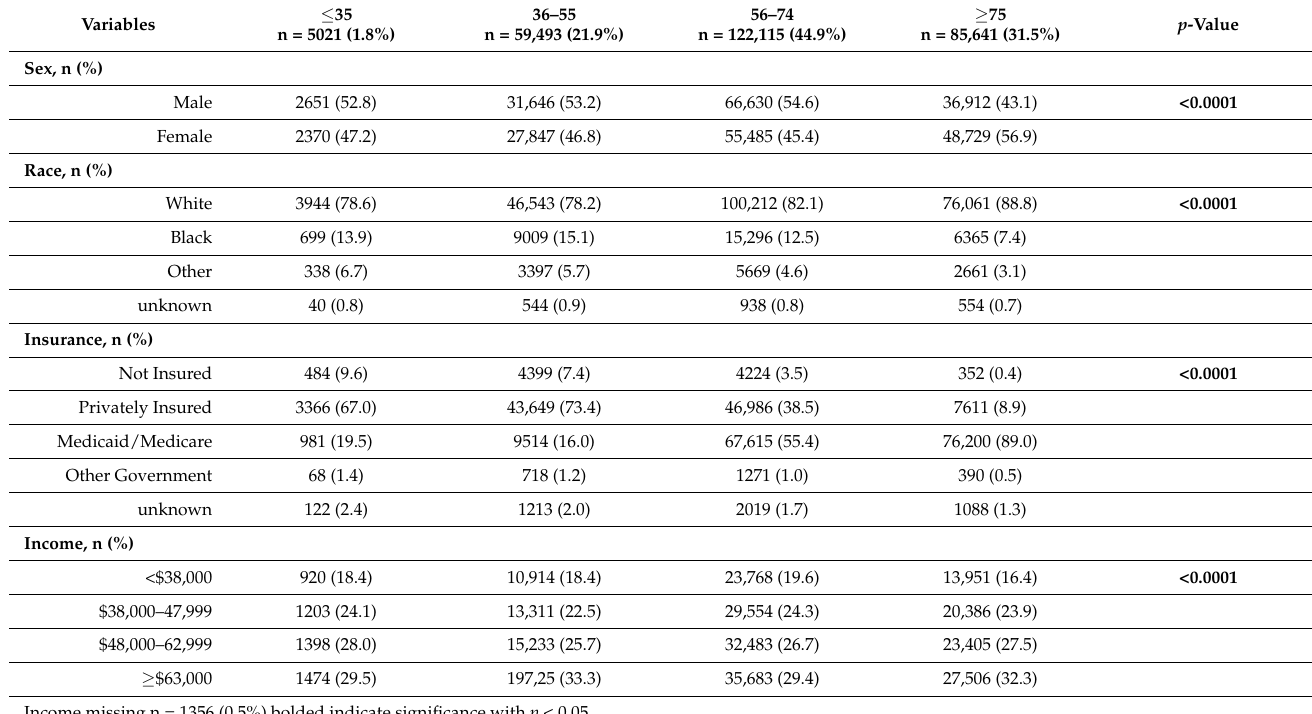
Table 1. Sociodemographic factors by age groups (n = 272,270).